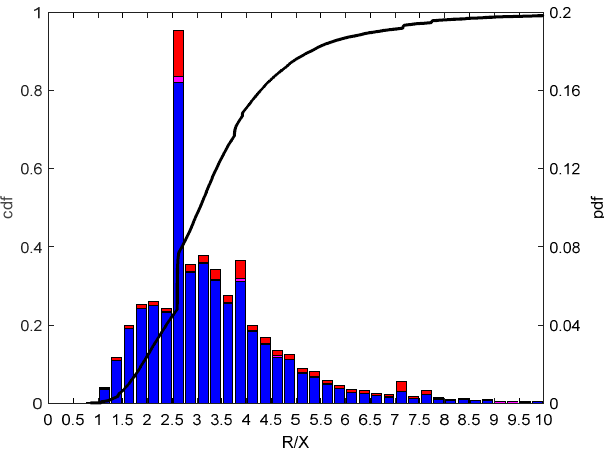
Figure 2. Distribution of the R/X ratio at the end node for the uniform generation distribution.